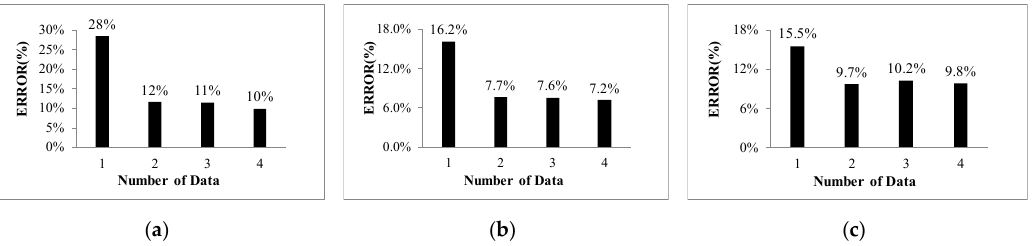
Figure 6. Sensitivity analysis for the optimized number of on-site data. ( a ) Gajwa IC viaduct; ( b ) Noryang bridge; ( c ) Geoje bridge.